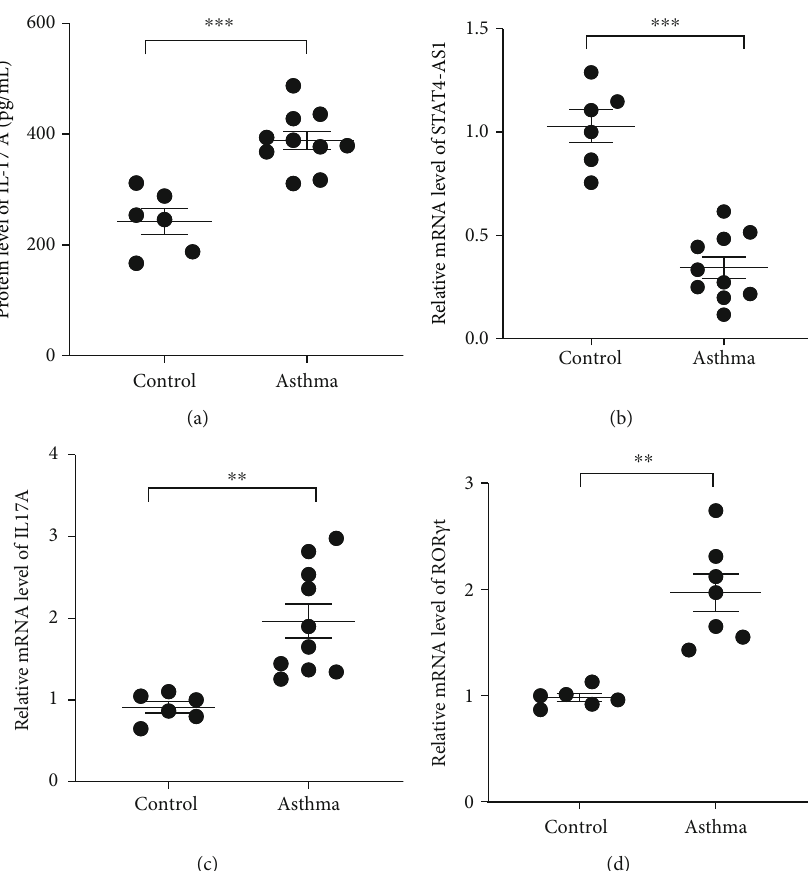
Figure 1: lncRNA STAT4-AS1 expression was downregulated accompanied by up-regulation of IL-17 expression in asthmatic patients. (a) The release of IL-17A in peripheral T cells of asthmatic patients was detected using ELISA. (b – d) The mRNA expression of lncRNA STAT4- AS1, IL-17A, and ROR γ t in peripheral blood T cells of patients with asthma was detected using Q-PCR. Three independent experiments were performed, and data are presented as the mean ± SD . ∗∗ p < 0 : 01 , and ∗∗∗∗ p < 0 : 001